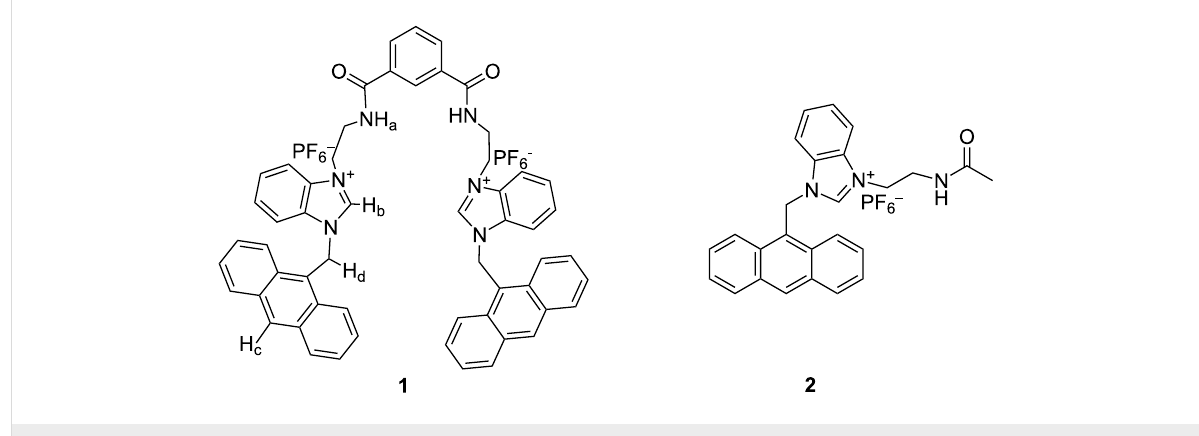
Figure 1: Synthesized compounds 1 and 2